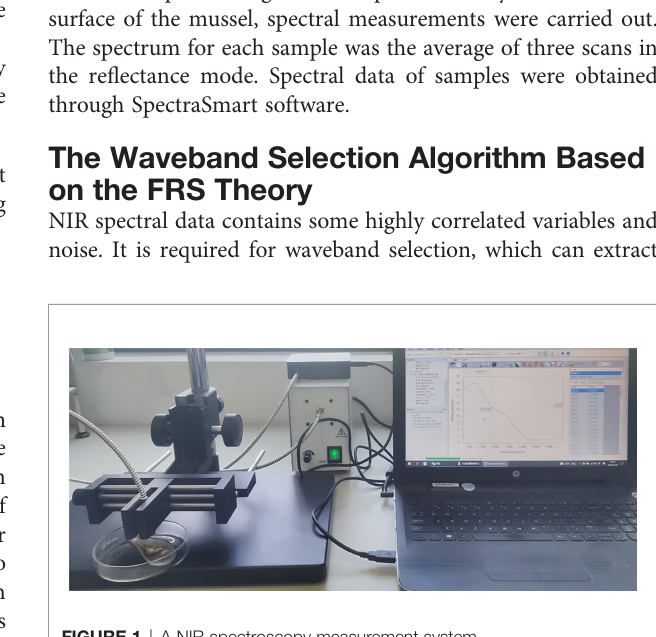
FIGURE 1 | A NIR spectroscopy measurement